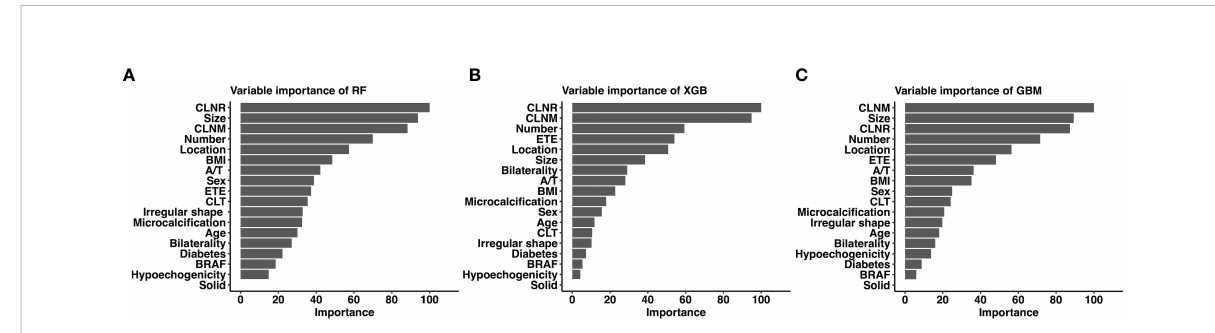
FIGURE 4 Relative importance ranking of each input variable for prediction of LLNM in the machine learning models. (A) Random Forest; (B) Gradient Boosting Machine; (C) Extreme Gradient